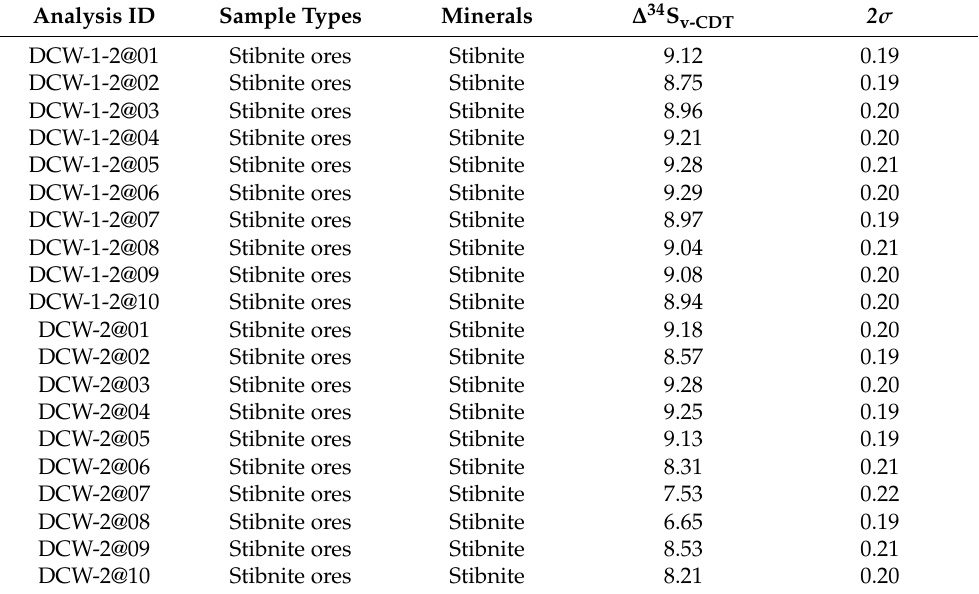
Table 1. In-situ sulfur isotopic compositions of sulfide minerals in the Daocaowan Sb deposit in central Hunan